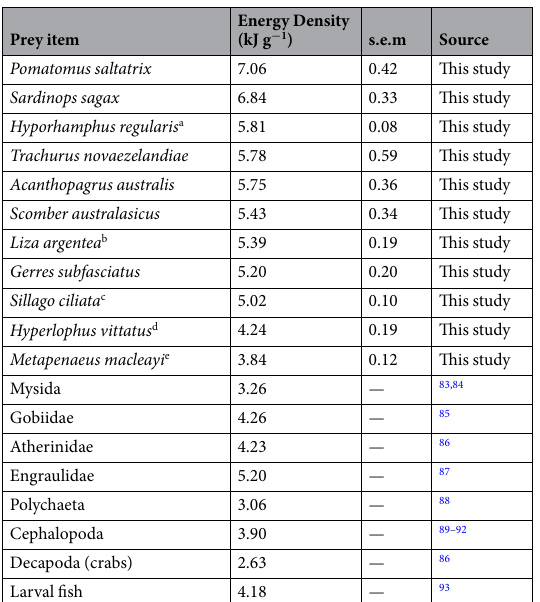
Table 1. Summary of mean values and standard error of the mean (s.e.m.) for energy density of representative tailor prey items measured by bomb calorimetry and used to calculate length-dependent mean energy density ( E ) of tailor prey. N = 10 for all species measured in this study. a Used as a proxy for all members of Hemiramphidae. b Used as a proxy for all members of Mugilidae. c Used as a proxy for all members of Sillaginidae. d Used as a proxy for all members of Hyperlophus . e Used as a proxy for all members of